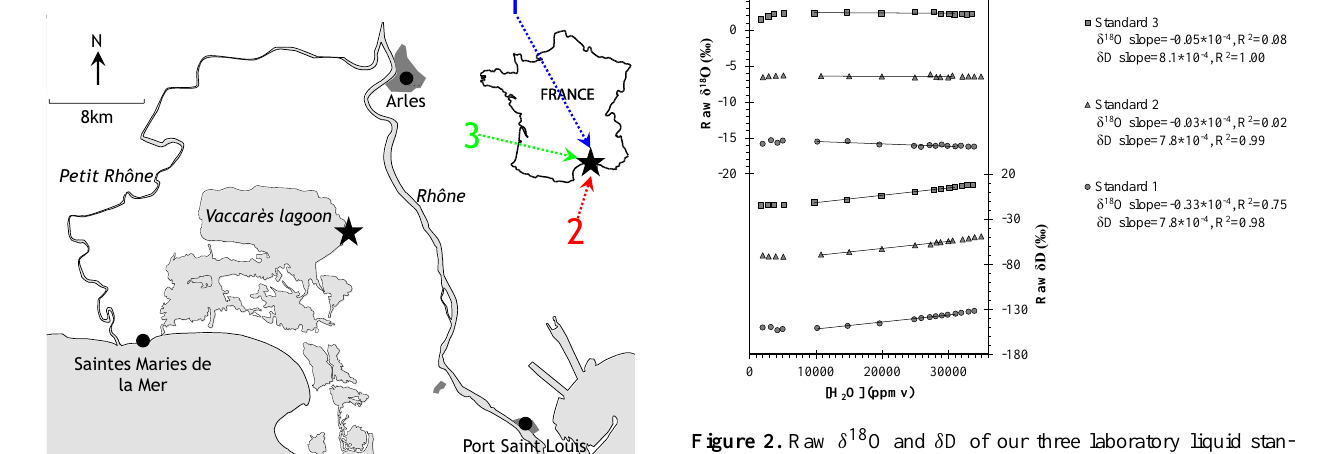
Figure 2. Raw δ 18 O and δ D of our three laboratory liquid stan- dards measured at various water vapour concentrations. Error bars are smaller than the symbols. Linear regressions within the concen- tration range encountered in Camargue during the field experiment and associated slopes and determination coefficients are